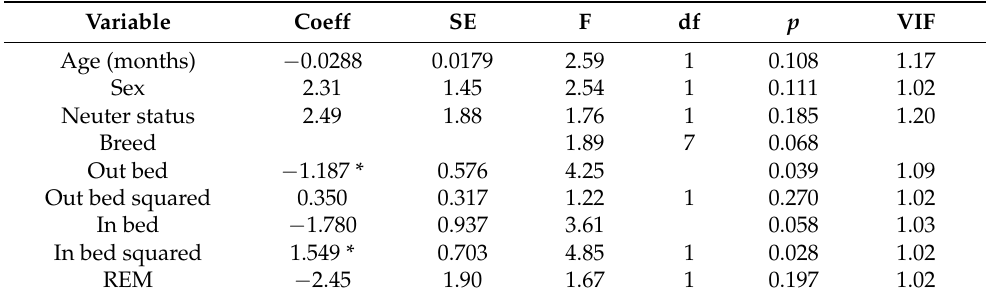
Table 4. General linear model output for